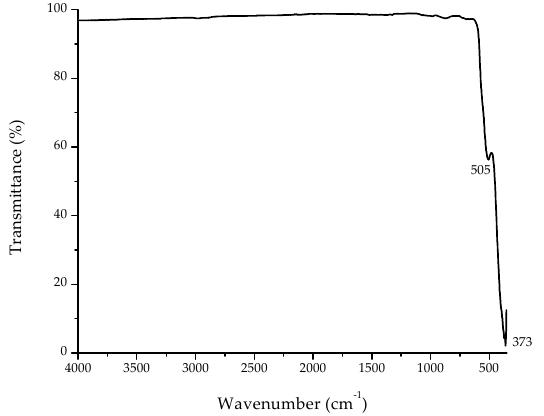
Figure 4. Fourier transform infrared spectroscopy with attenuated total reflection (FTIR-ATR) spectrum of synthesized flower-shaped ZnO nanostructures.